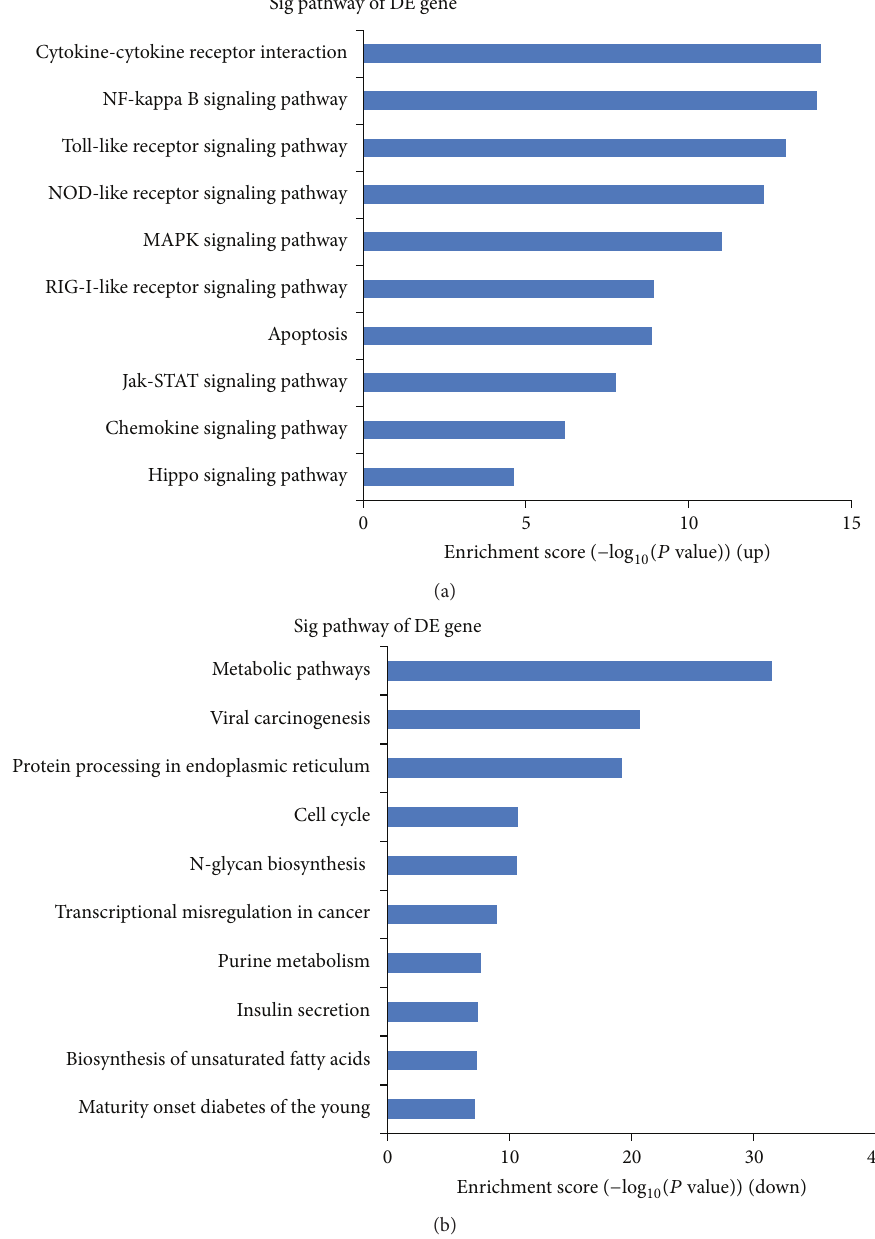
Figure 5: Pathway analyses. (a) The top 10 pathways that associated with coding gene of upregulated lncRNAs are listed. (b) The top 10 pathways that associated with coding gene of downregulated lncRNAs are